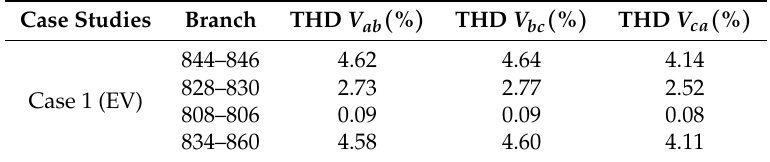
Table 3. Phase to Phase Voltage total harmonic distortions (THDs) for Low EV